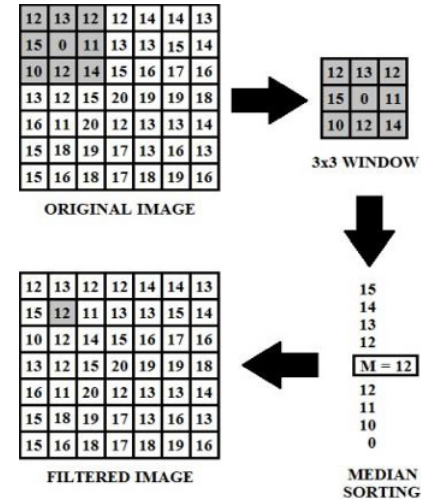
Fig. 2. Median filter process [3].